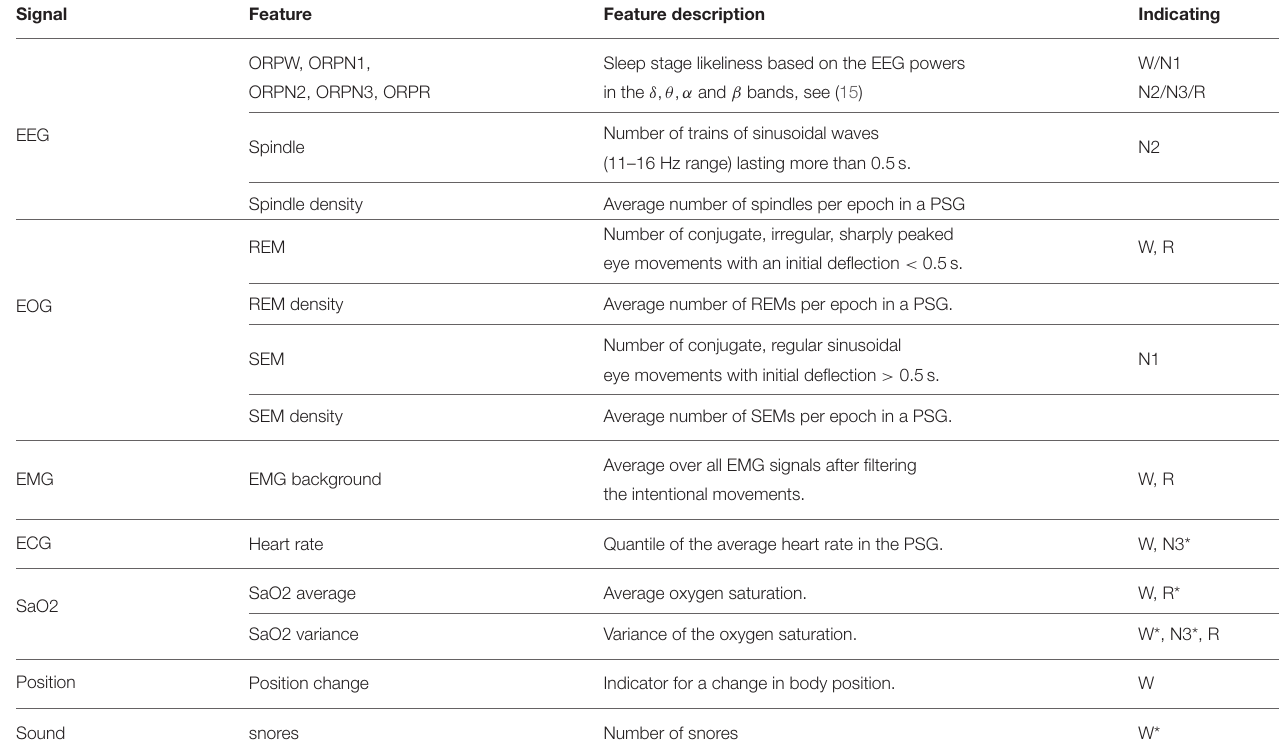
TABLE 1 | Table summarizing all features per